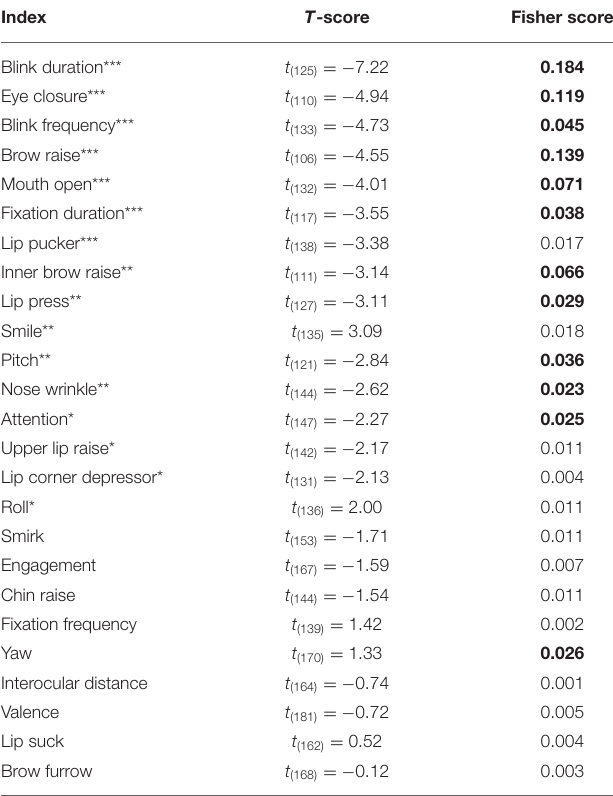
TABLE 1 | Results of t -test and Fisher